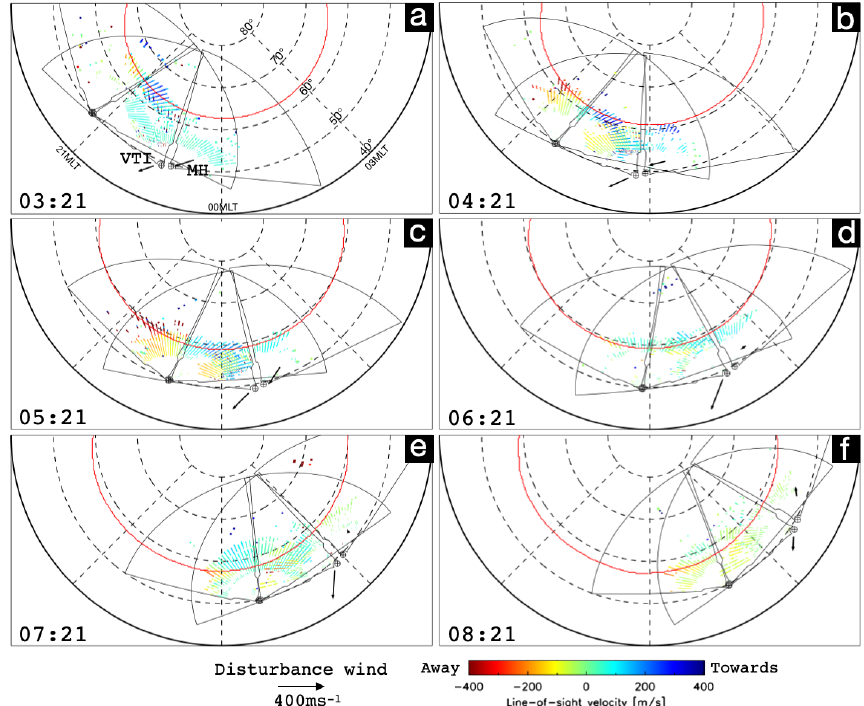
Figure 4. Nightside polar plots of plasma velocity data from four SuperDARN radars and disturbance neutral wind velocity vectors from the VTI and MH FPIs (black arrows) for times on 9 November 2013. The red circle is the approximate location of the auroral oval lower-latitude boundary, derived from Special Sensor Ultraviolet Spectrographic Imager (SSUSI) data aboard whichever Defense Meteorological Satellite Program (DMSP) instrument (F-16, F-17, or F-18) last crossed the pole. There are six times shown 1h apart each, the coordinate system is AACGM latitude magnetic local time, and the concentric dashed lines separate 10 ◦ of latitude. Data in each SuperDARN radar beam have been made thinner to help show which radar it was measured by and, thus, the LOS direction. The VTI FPI is the arrow with a base at a slightly lower latitude compared to the MH